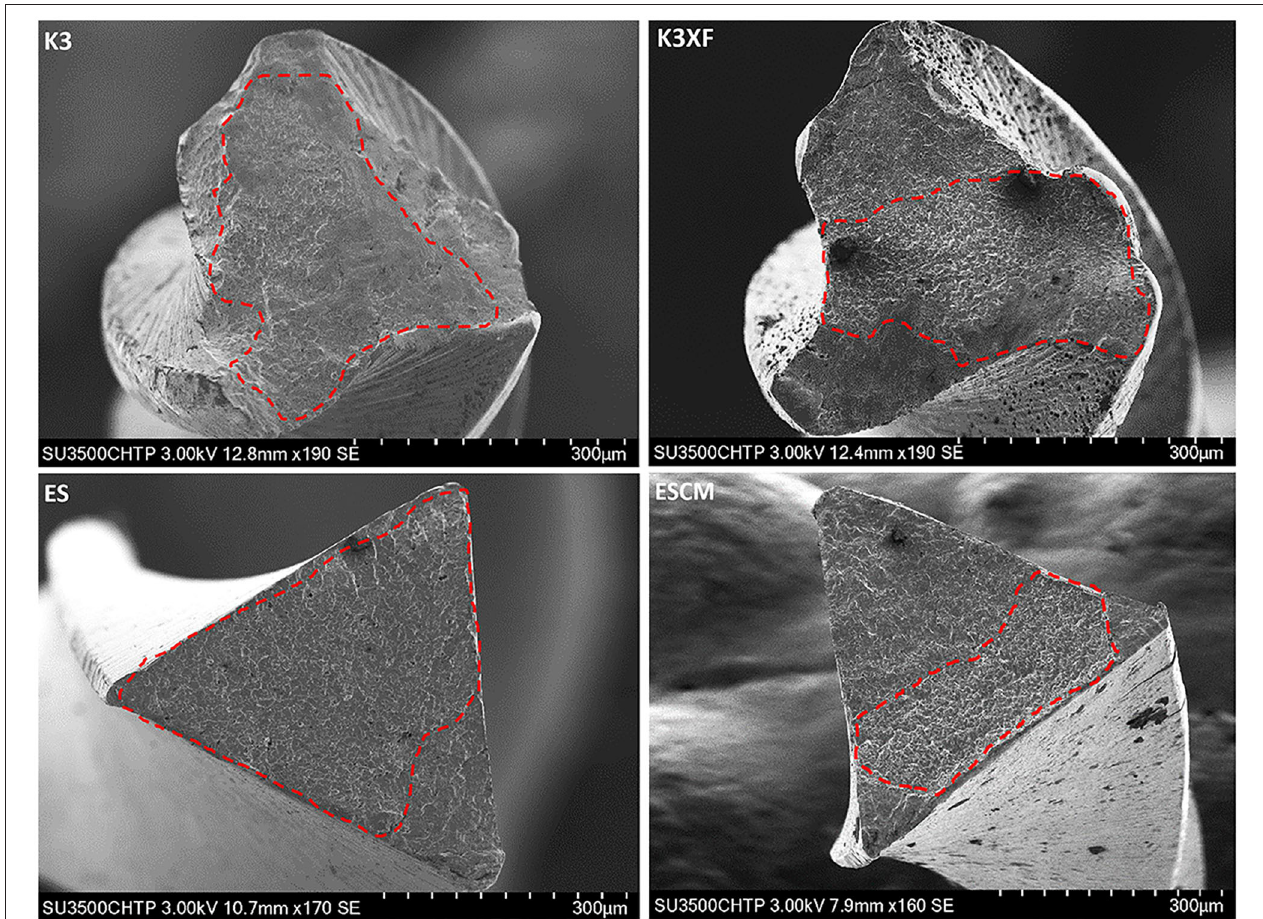
FIGURE 2 | The photomicrograph of the fracture surface of NiTi instruments with the region of crack propagation and dimple area outlined (dotted